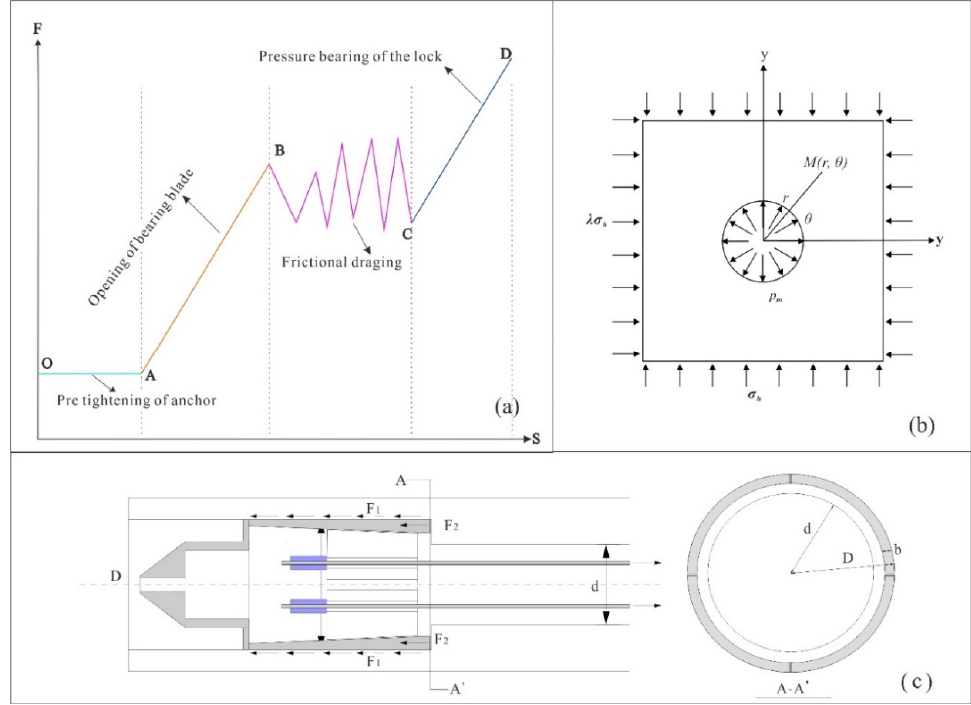
Figure 6. Mechanical diagrams of the MSEAs. ( a ) The bearing process of the MSEAs without grout- ing; ( b ) the mechanical diagram of the bearing blades; and ( c ) the mechanical diagram of the